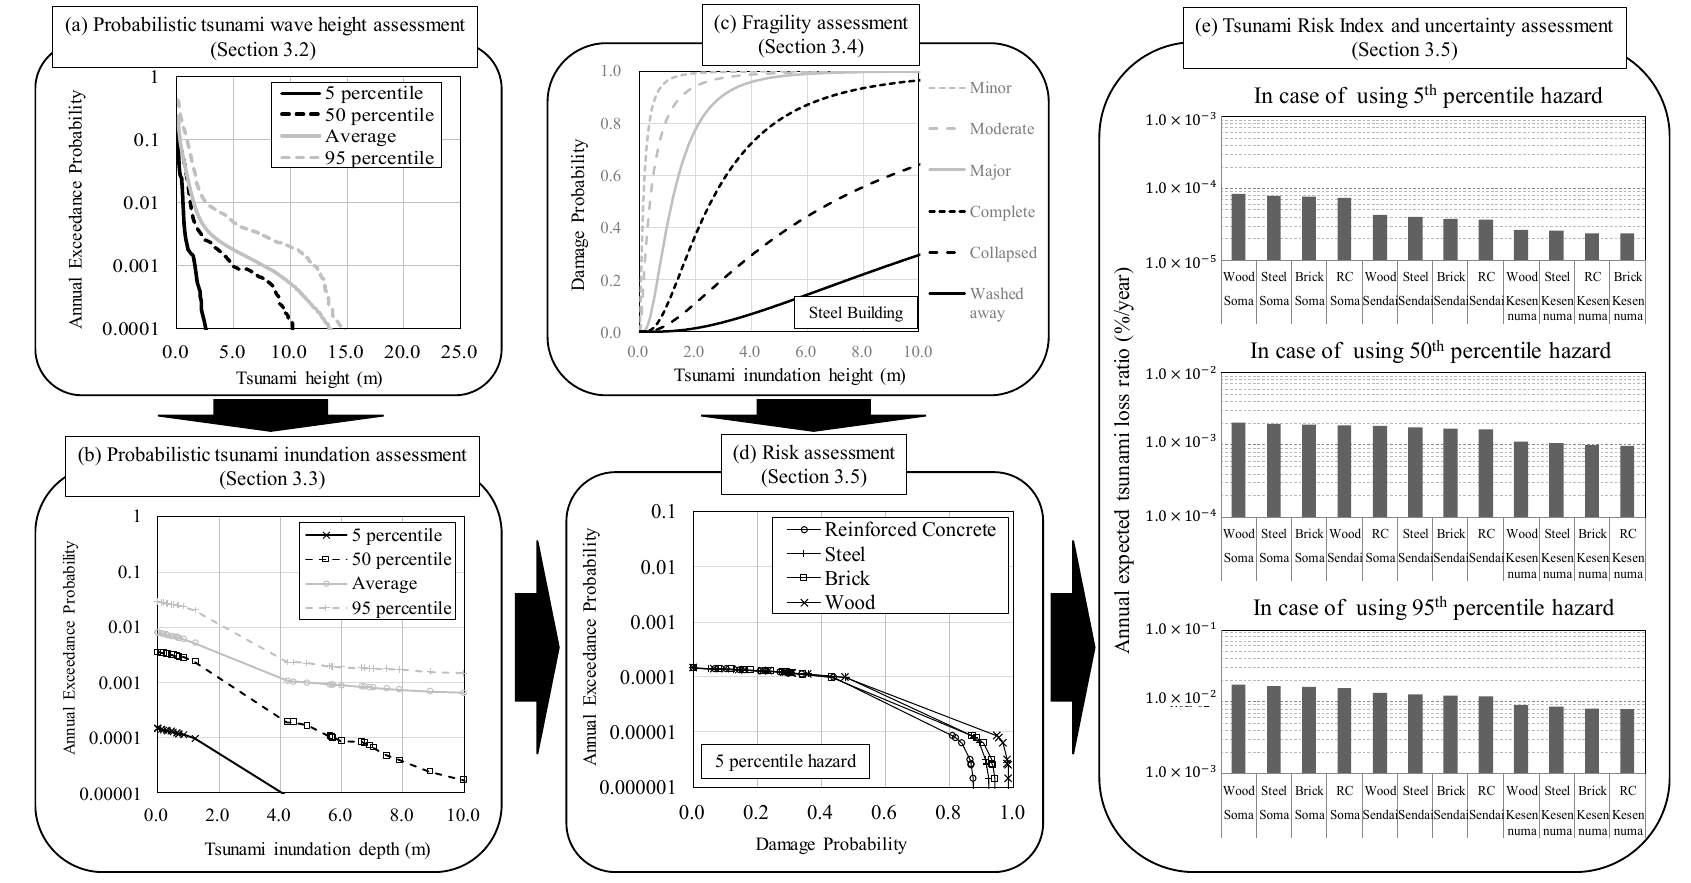
Figure 2. Flow of the tsunami risk quantification. ( a ) The probabilistic tsunami wave height is converted to ( b ) the probabilistic tsunami inundation information, and ( d , e ) the risk assessment is carried out by combining the hazard information with ( c ) fragility assessment.